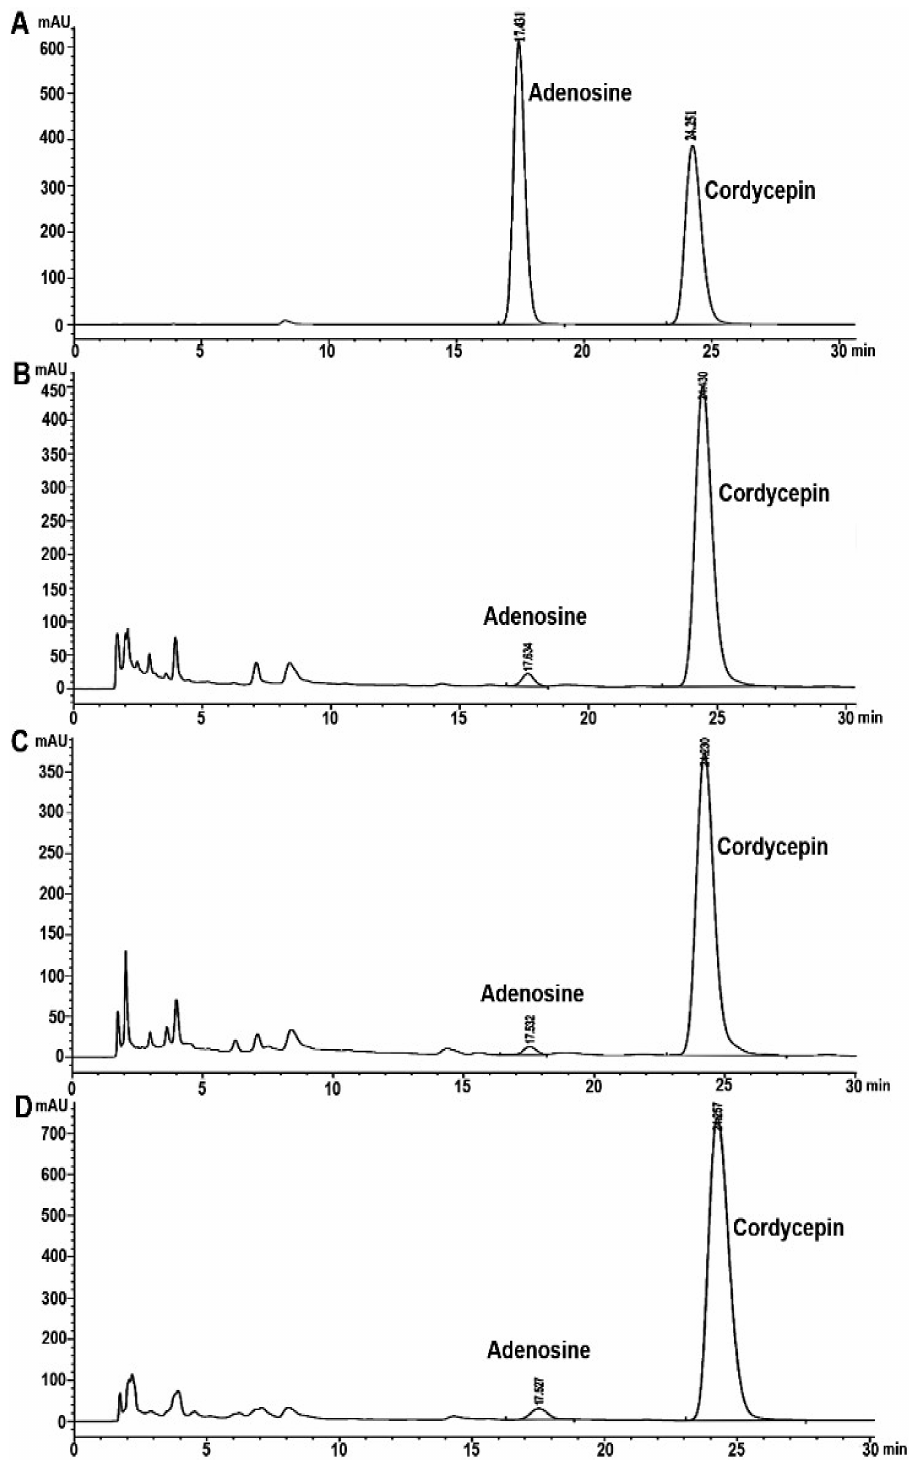
Figure 3. HPLC chromatograms of cordycepin and adenosine founded in the ethanolic extracts of C. militaris by HPLC method: ( A ) Standard compounds of cordycepin and adenosine; ( B ) Sample A; ( C ) Sample B; ( D ) Sample